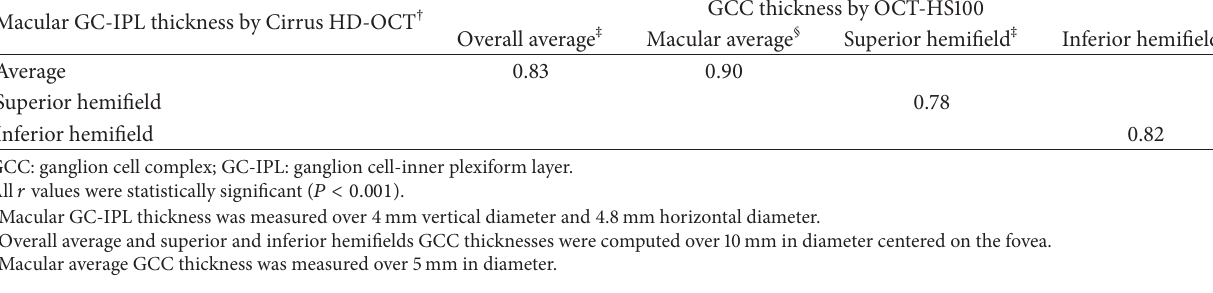
Table 2: Pearson’s correlation coefficient ( 𝑟 ) between GCC thickness by OCT-HS100 and GC-IPL thickness by Cirrus HD-OCT ( 𝑛 = 92). Macular GC-IPL thickness by Cirrus HD-OCT